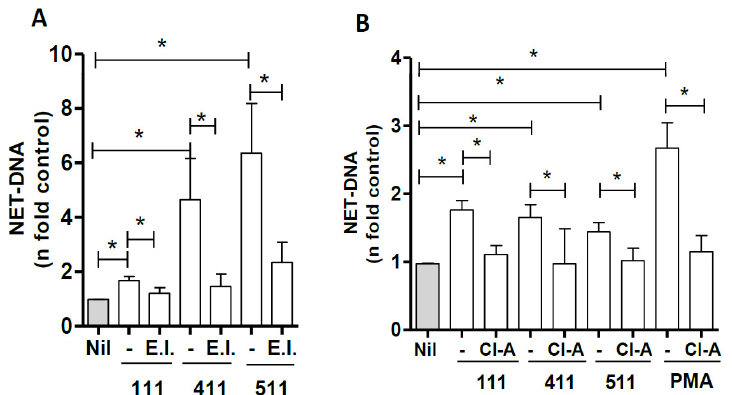
Figure 3. Involvement of Elastase and PAD4 in NET induction by the LM isoforms 111, 411, and 511. Neutrophils were either untreated (Nil) or treated for 30 min with elastase inhibitor (E.I.–A) or PAD-4 inhibitor, chloroamidine (Cl-A–B) and then incubated with LMs 111, 411, and 511 in suspension for 60 min. NETs in culture supernatants were quantified using PicoGreen. The data were normalized according to spontaneous release of DNA from unstimulated neutrophils (Nil) and are presented as the mean ± SEM of 9, 3, and 3 donors for LMs 111, 411, and 511, respectively ( A ); 8, 4, and 4 donors for LMs 111, 411, and 511, respectively ( B ). The data from PMA, which were used as a control, are from 4 donors ( B ) * p < 0.05.